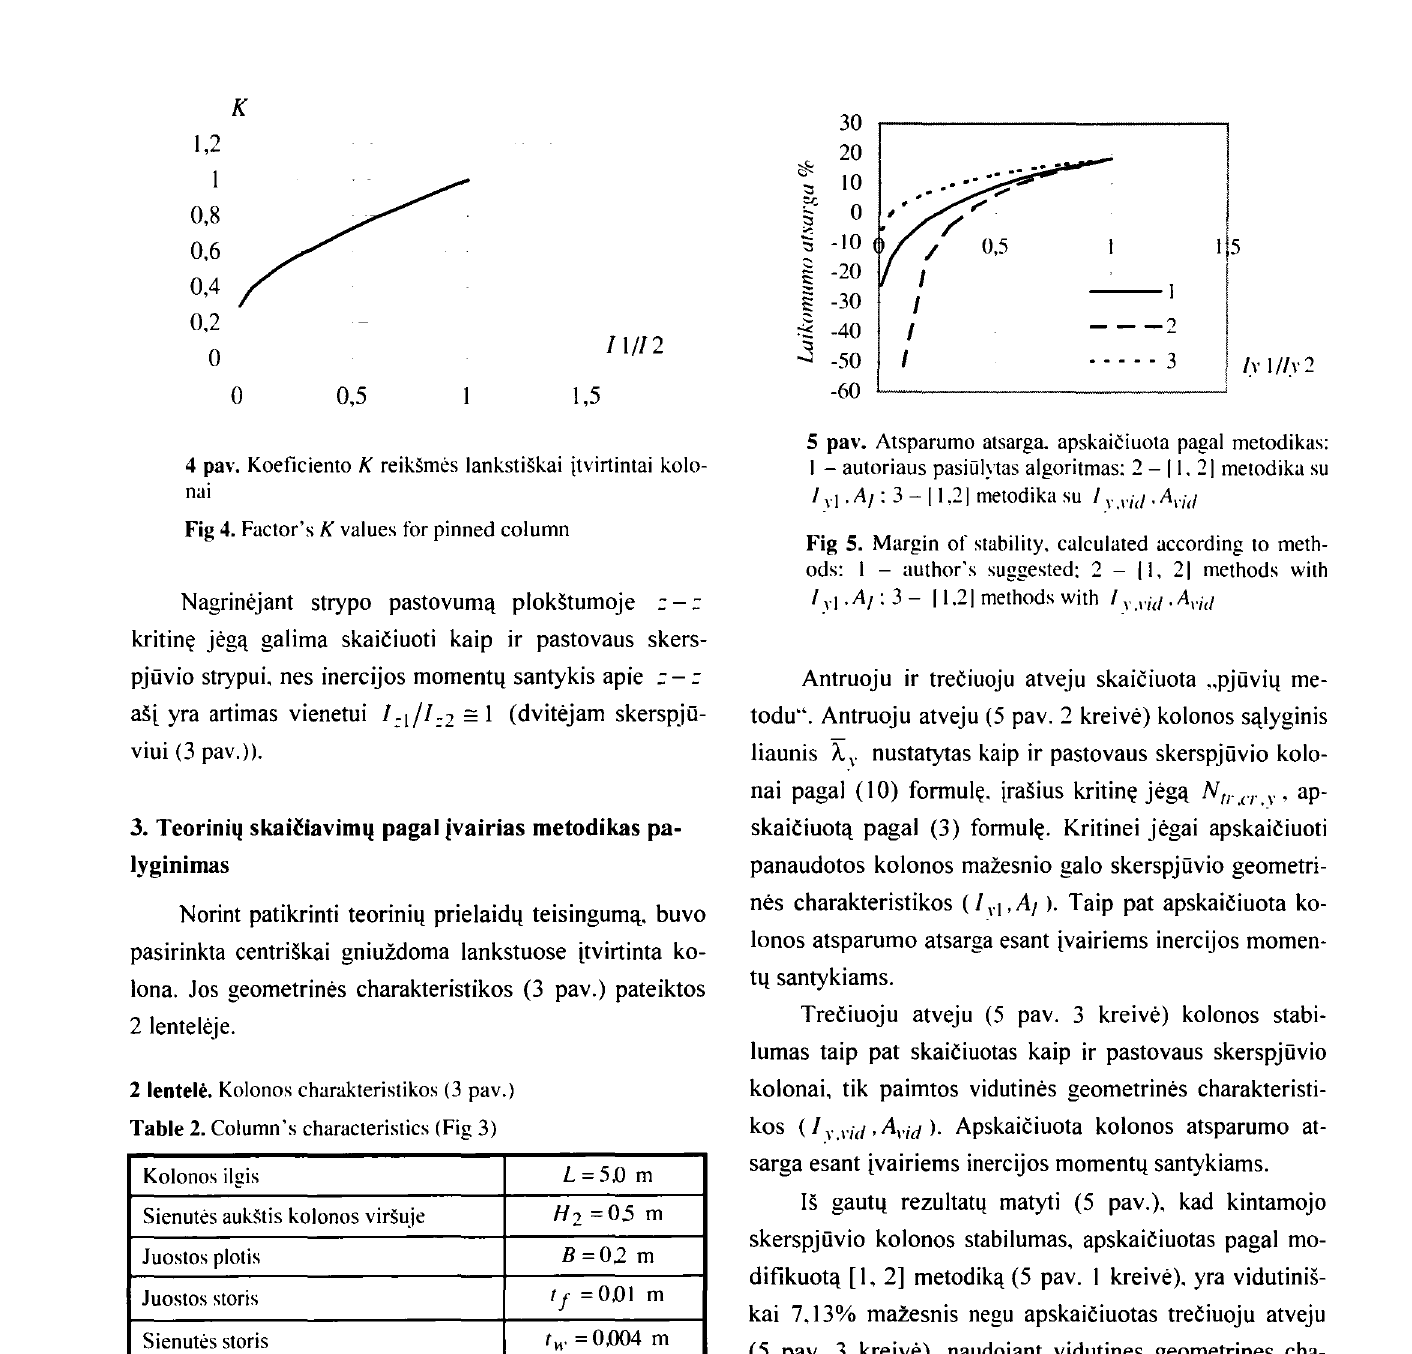
Table 2. Column's characteristics (Fig 3) Kolonos ilgis Sienutes aukstis kolonos virsuje Juostos plotis Juostos storis Sienuti:s storis Gniuzdomoji jega Atlikta daug skaiciavimtt keiciant apatini kolonos skerspjuvio sienutes auk~ti taip, kad inercijos momenttt Skaiciavimai buvo atlikti pagal [I, 2] metodik~ trim biidais. Pirmuoju atveju (5 pav. I kreive) kolonos kritine N,,. jega .cr .r apskaiciuota pagal (9) formul~ taikant koe ficient~ K . Apskaiciuota centriskai gniuzdomos trapeci nes kolonos atsparumo atsarga esant ivairiems inercijos moment4 santykiams.